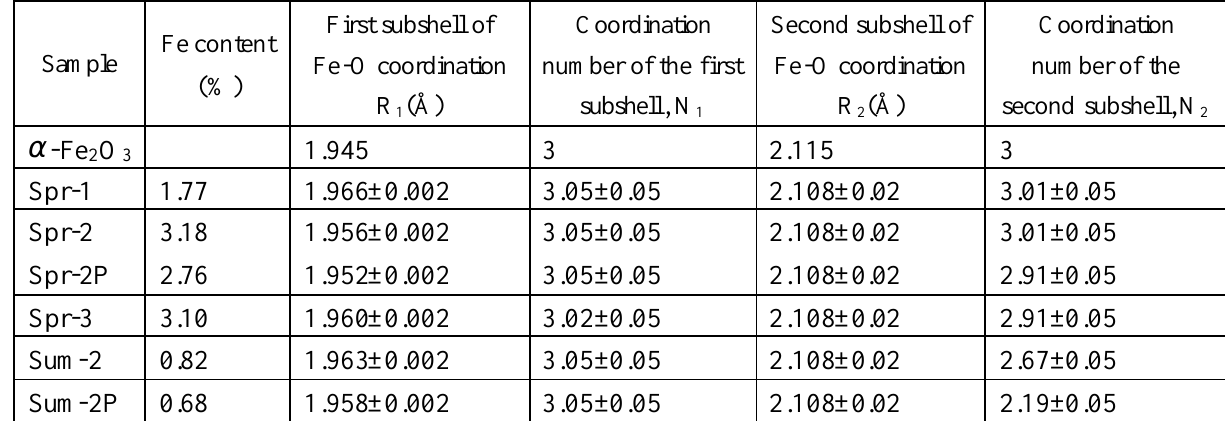
O and aerosol 2 3